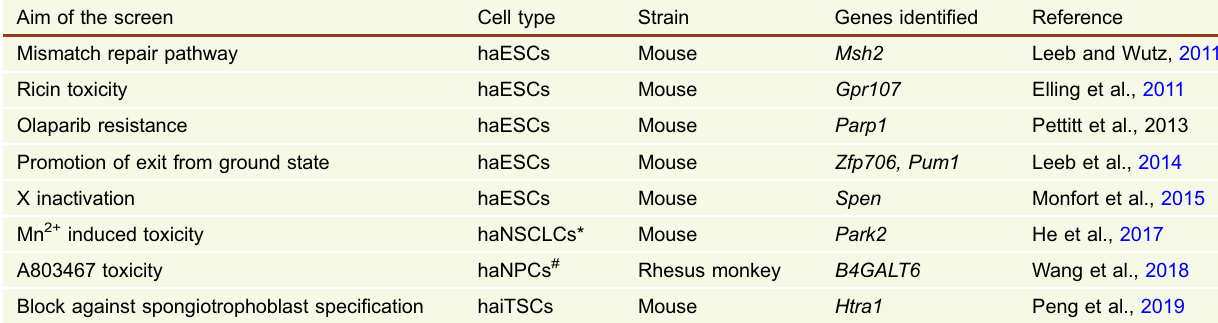
Table 1. Genetic screens in haploid cell systems Aim of the